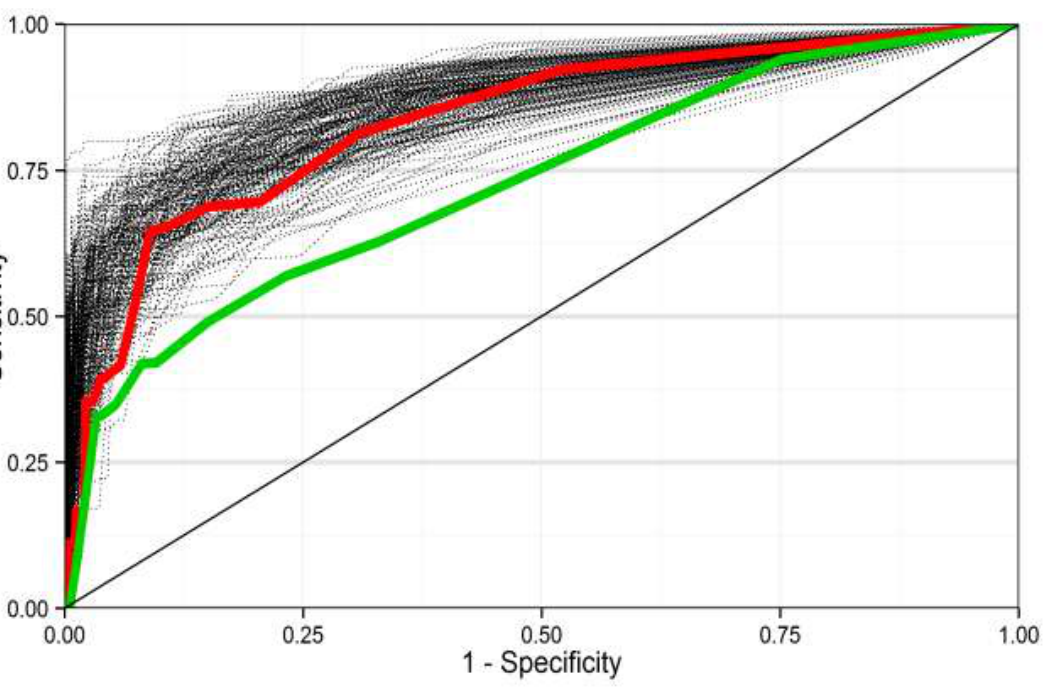
Figure 1. Areas under the receiver operating characteristic curves from the 500 bootstrapped samples for the new screening model (red) and the current screening model (green).